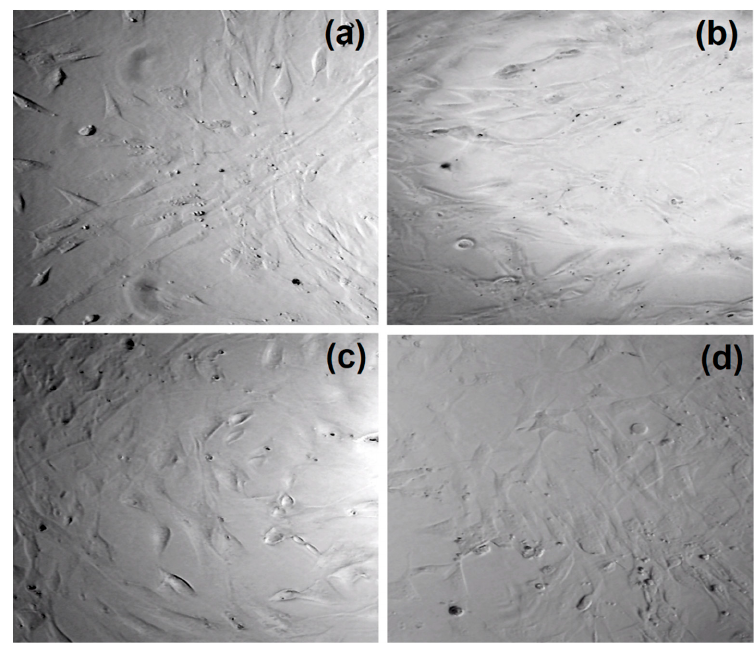
Figure 8. Microphotographs of human dermal fibroblasts cultured with CQDs after 48 h, ( a ) CQDs-3, ( b ) CQDs-4, ( c ) CQDs-12, ( d ) control.